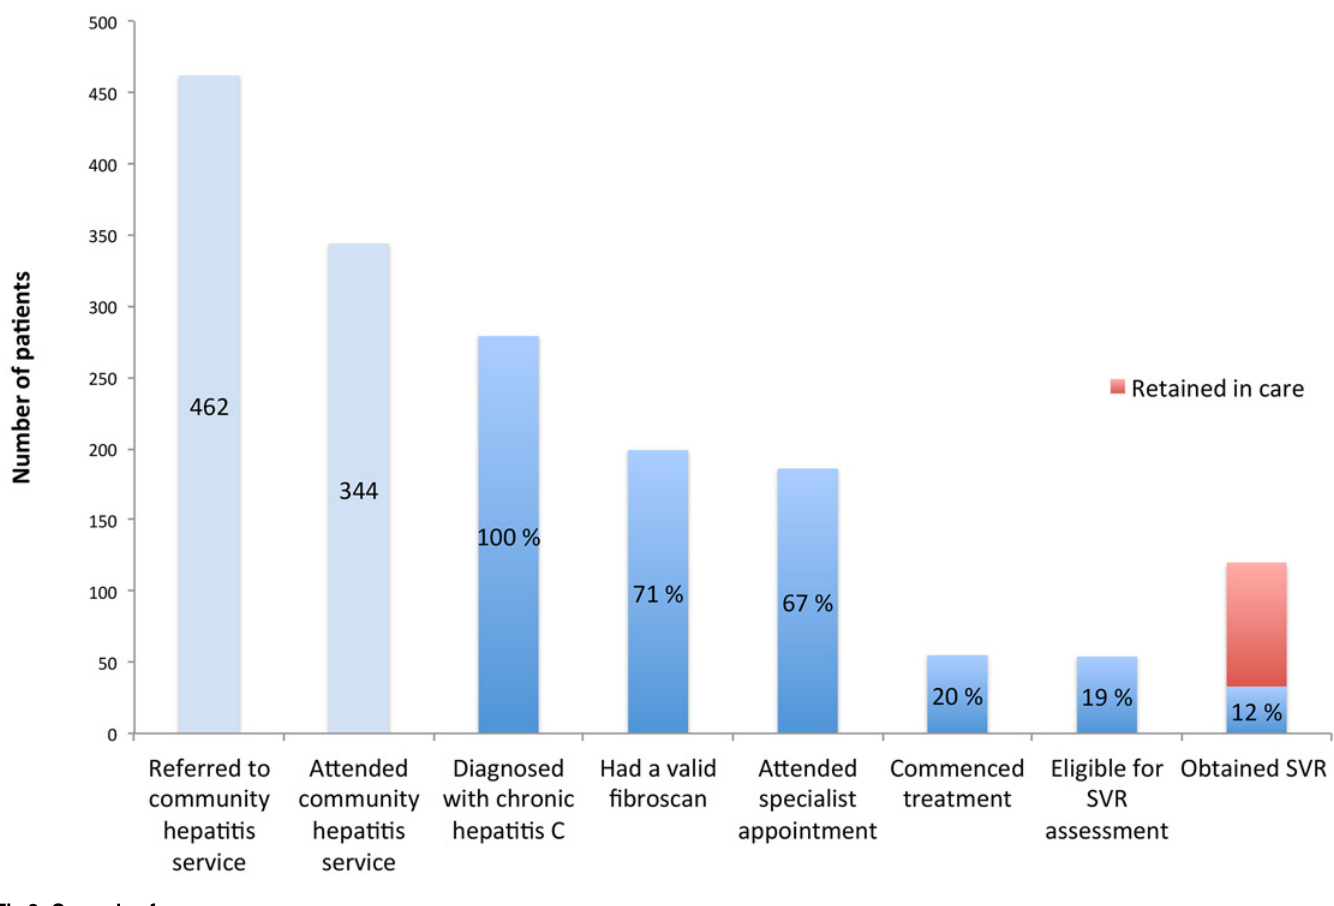
Fig 2. Cascade of care.